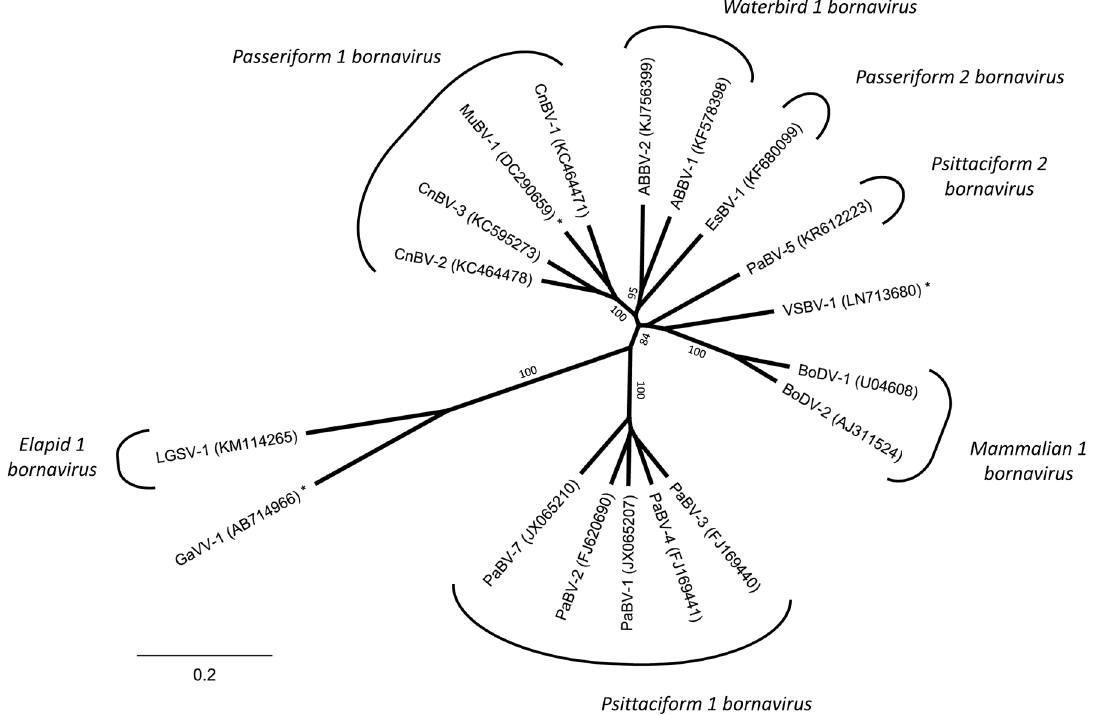
Fig 1. Taxonomy of the Bornaviridae family. Complete P gene sequences of representative bornavirus sequences analysed using Neighbor-Joining algorithm and Jukes-Cantor distance model in Geneious R8. Values at branches represent support in 1,000 bootstrap replicates. Only bootstrap values (cid:1) 70 at major branches are shown. Bornaviruses marked with asterisks are not classified following the currently accepted taxonomy [2]. ABBV = aquatic bird bornavirus, BoDV = Borna disease virus, CnBV = canary bornavirus, EsBV = estrildid finch bornavirus, GaVV = Gabon viper virus, LGSV = Loveridge´s garter snake virus, MuBV = munia bornavirus, PaBV = parrot bornavirus, VSBV = variegated squirrel